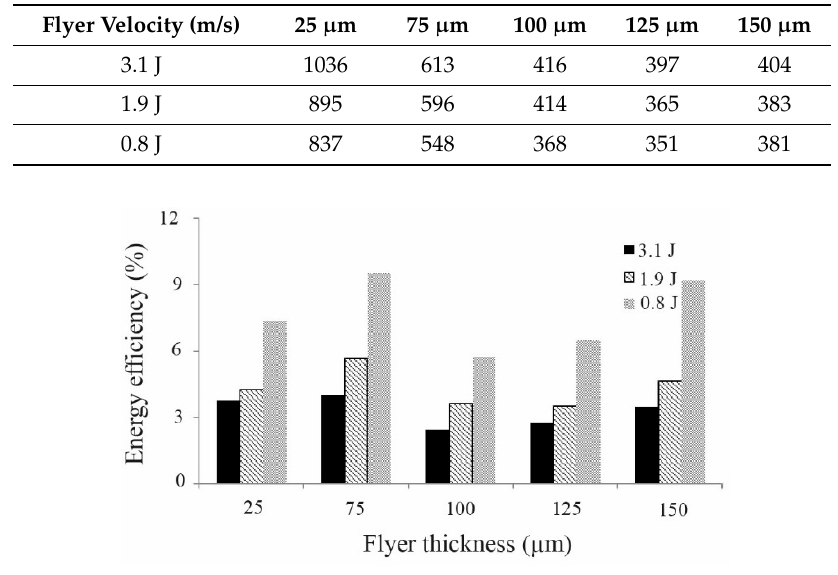
Figure 3. Energy efficiency with various laser energy and flyer thickness ( D = 2 mm, L = 100 μ m).